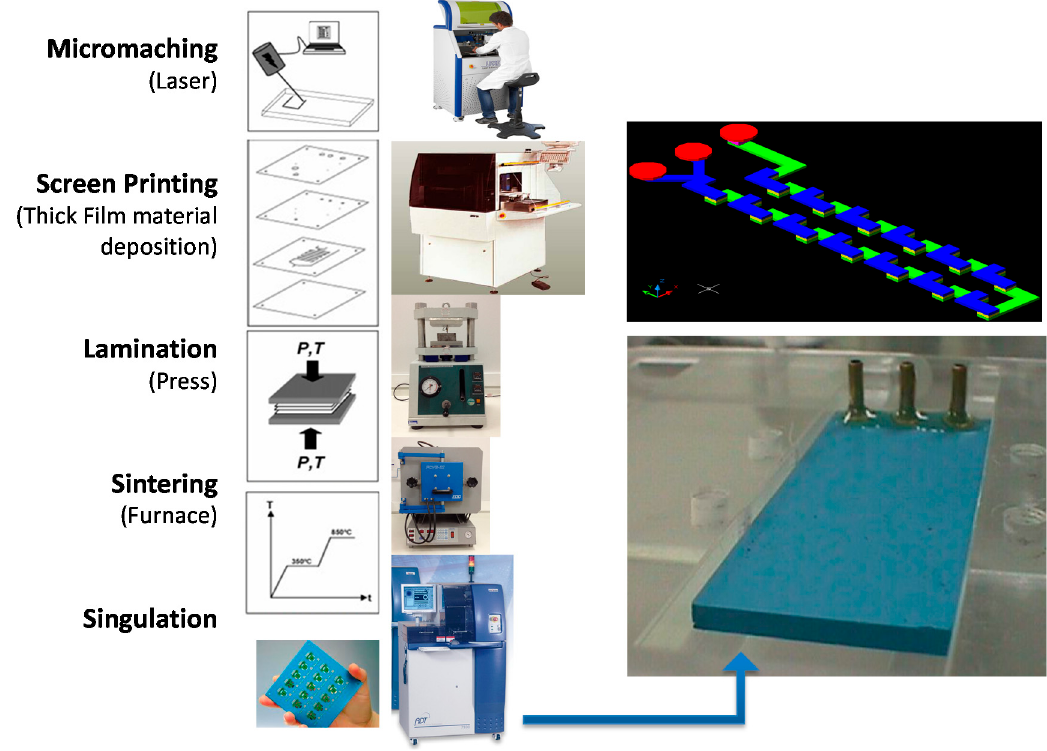
Figure 1. Low temperature co-fired ceramic ( LTCC) process to fabricate microfluidic devices.